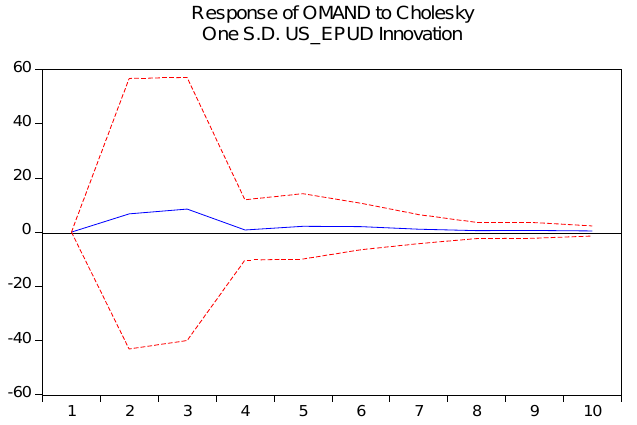
Fig. 2. The impulse response functions of the returns on Kuwait stock market to changes in the U.S. economic policy uncertainty (2004:M7 – 2018:M8)